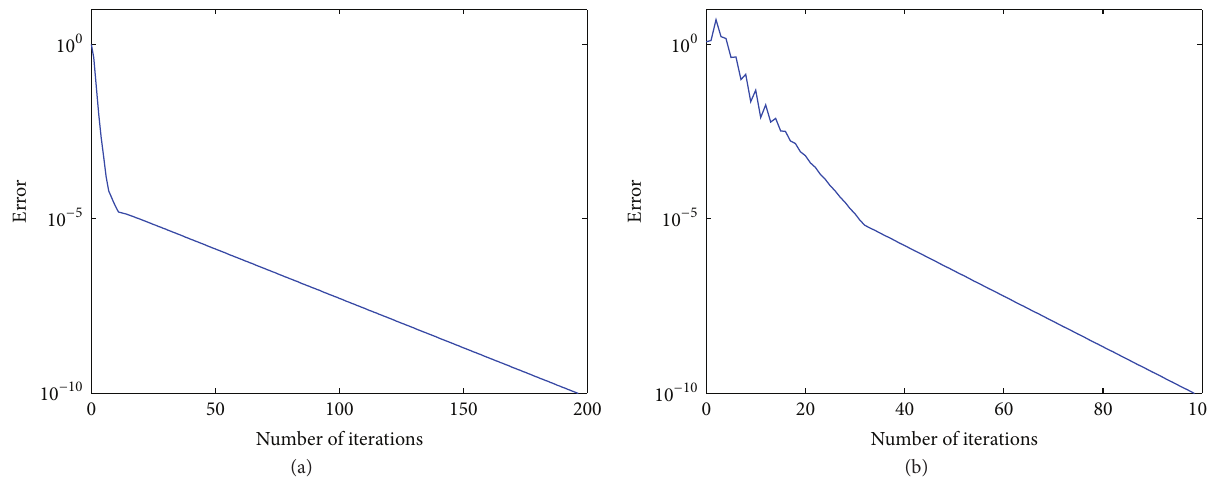
Figure 3: Convergence analysis for lattice soliton corresponding to the first renormalization factor with 𝜇 = 1.3 ; (b) convergence analysis for lattice soliton corresponding to the second renormalization factor with 𝜇 = 1.5